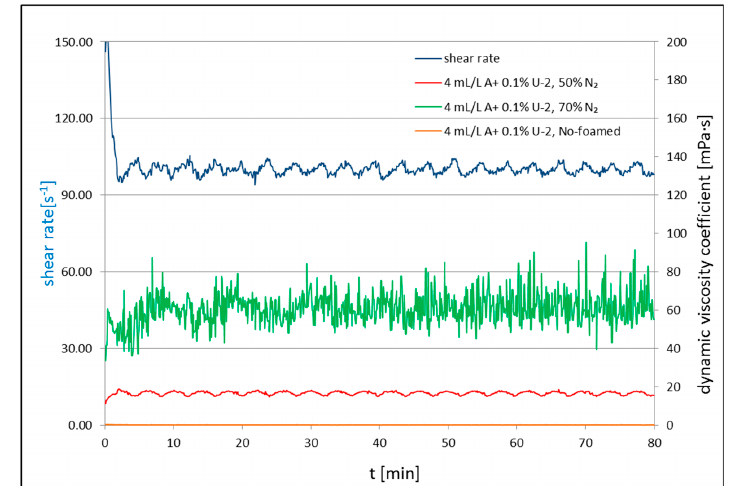
Figure 3. Viscosity of non-foamed and N 2 foamed fluid of 50% and 70% quality at 23 °C at a shear rate of 100 s − 1 .